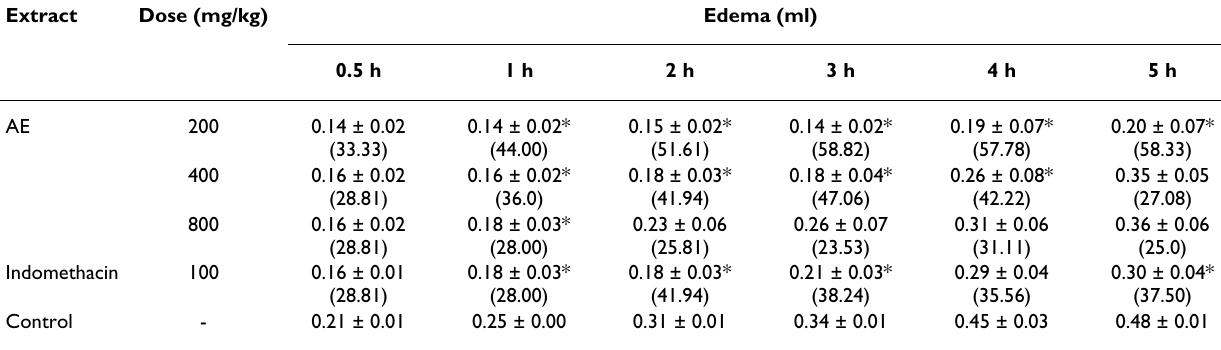
Table 3: Effect of extract on agar-induced acute edema of the rat paw Extract